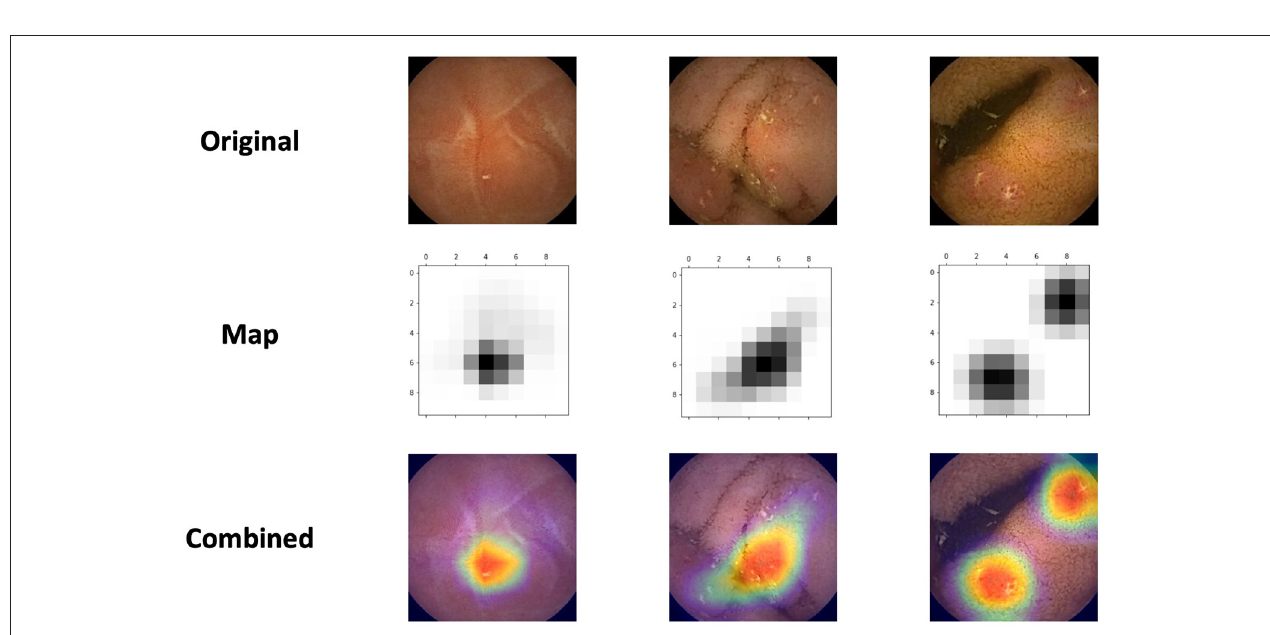
FIGURE 2 | Convolutional neural networks (CNN) are a sub-type of artificial neural networks (ANN). CNNs, are unique in their capacity to identify repeating patterns. Thus, they are ideal for image analysis, as images contain many repeating patterns. CNNs are composed from many small matrixes which are a collection of weights. These small matrices are shared across the array of pixels which constitutes an